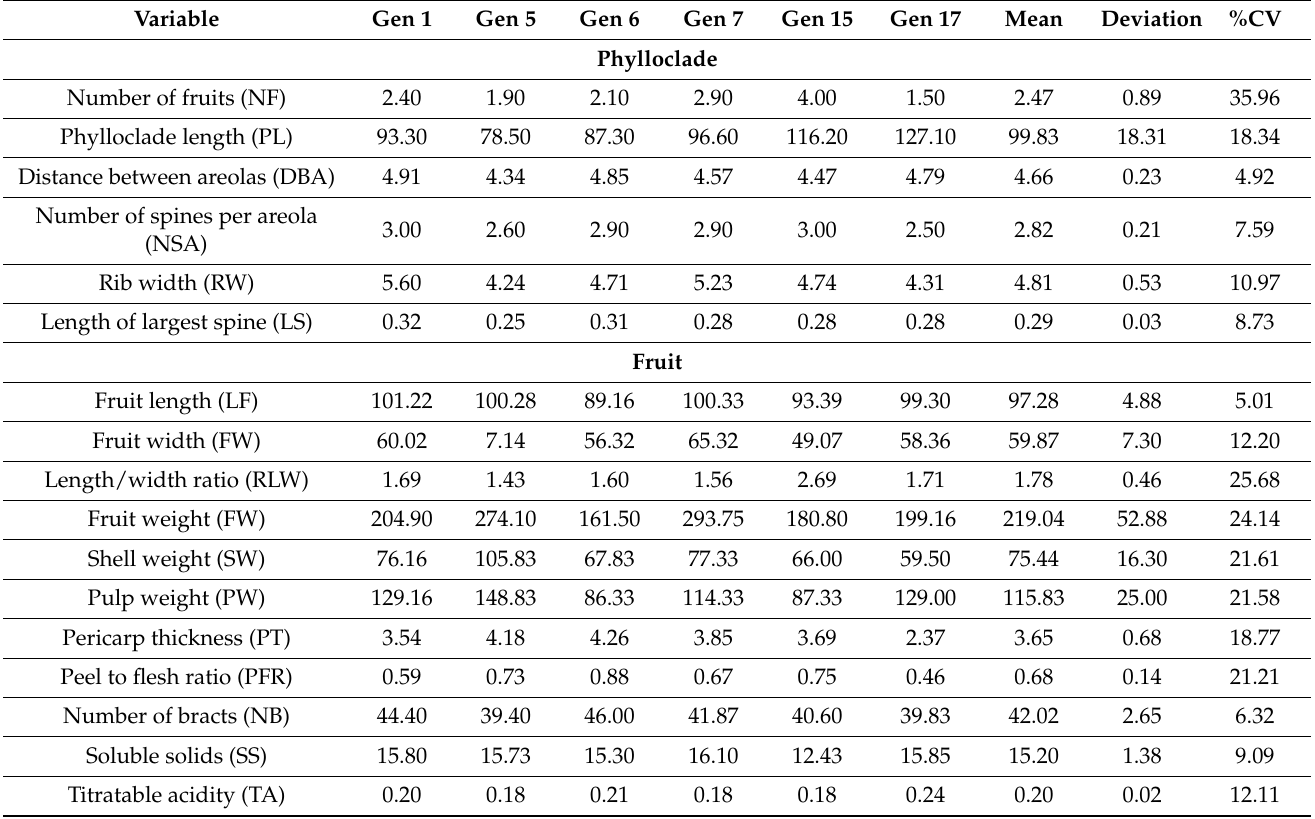
Table 5. Descriptive statistics of quantitative morphoagronomic descriptors of fruits and phylloclades in open-field